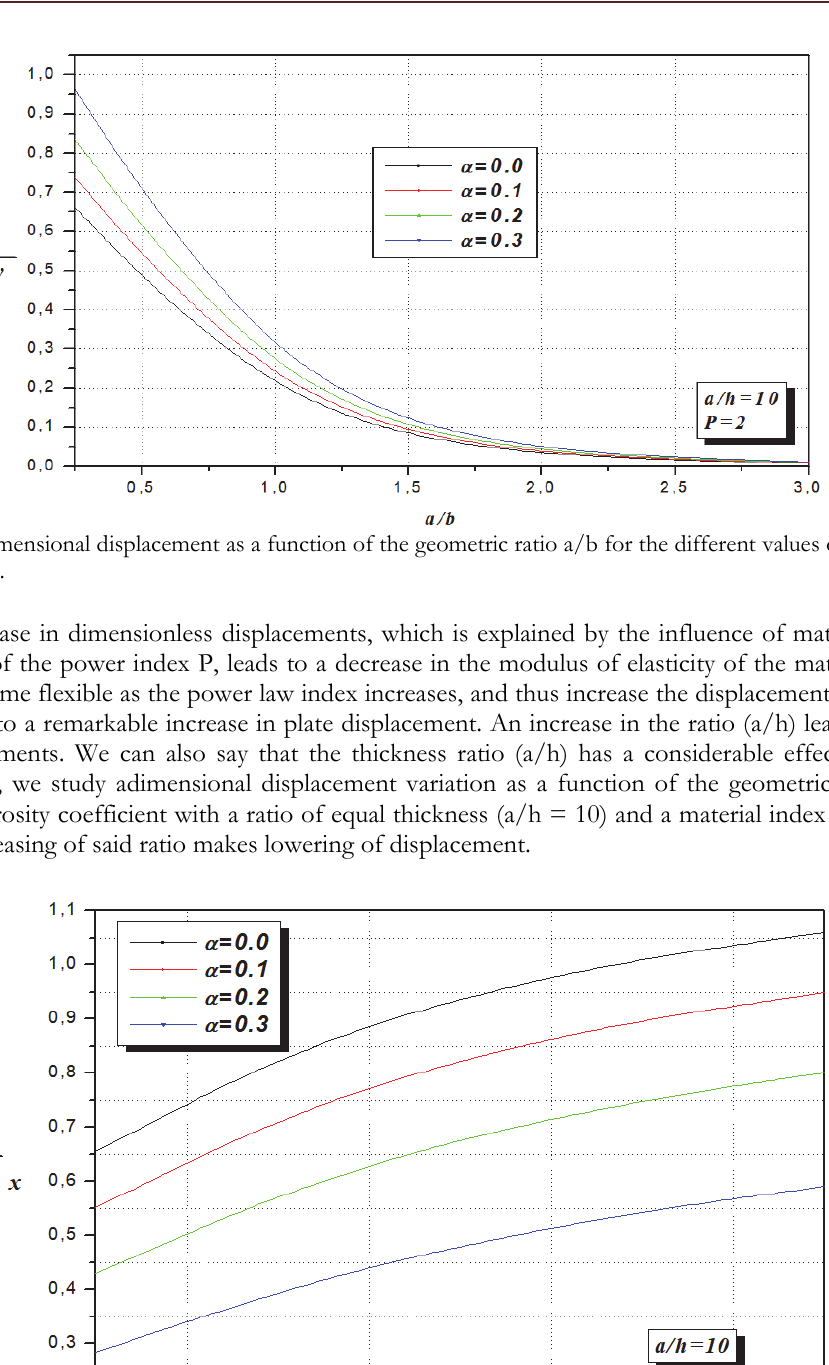
Figure 7: Variation of stress non-dimensional plate